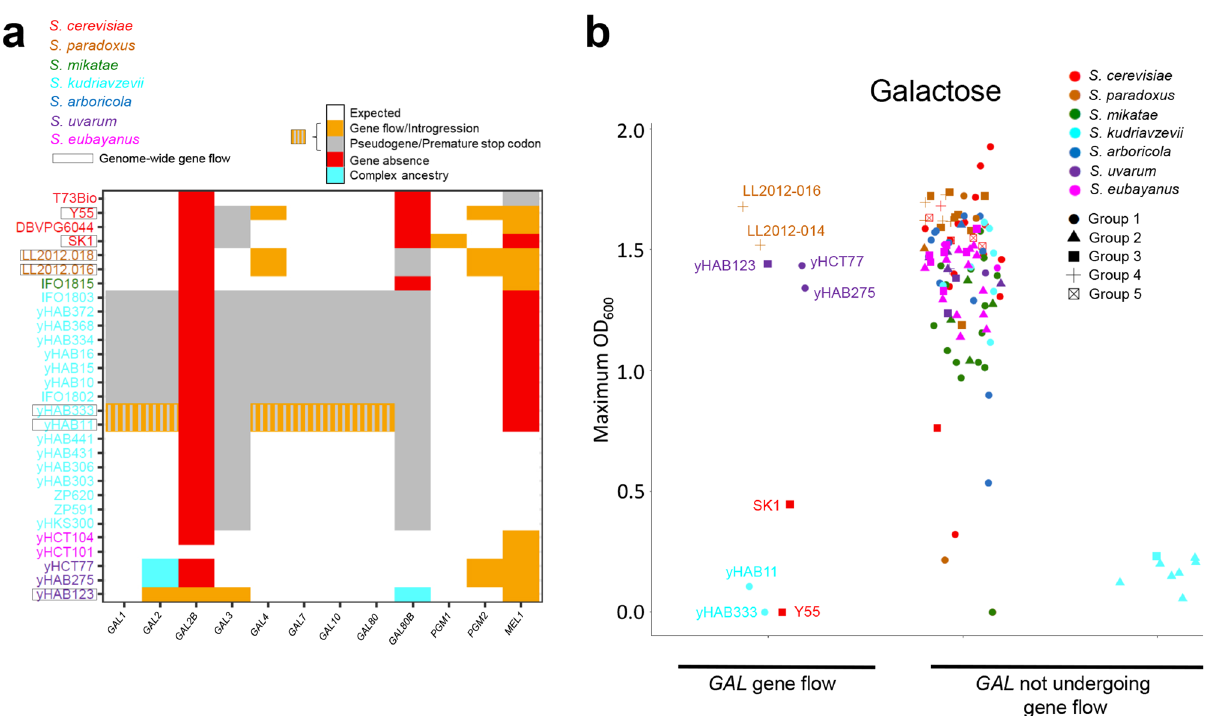
Fig. 6 | Phenotypic diversity and complex ancestries. a Saccharomyces strains affected by gene fl ow for the GAL regulon genes. Names of strains with genome- wide admixture (Supplementary Data 3) are boxed. Strain names are colored according to species designations. Complete genes with a phylogenetic position (Supplementary Fig. 28) as expected based on population genomic analysis (Sup- plementary Fig. 9) are labeled as white. Genes acquired from another lineage by gene fl ow are labeled orange. Genes with premature stop codons or in a more advanced state of pseudogenization are labeled gray. Genes with complex ances- tries, such asunexpectedly ancient alleles, arelabeled cyan.Genesnot detectedby any of the methods employed in this study (see Methods) were considered absent andarelabeledred. b) Maximumbiomassproduction(OD 600 )on2%galactosefor Saccharomyces strains ( n =125, Supplementary Data 6). Each point is a strain colored by species designation. Data were split based on whether (left) or not (right) gene fl ow had occurred. Asia A and B S. kudriavzevii (on the right)